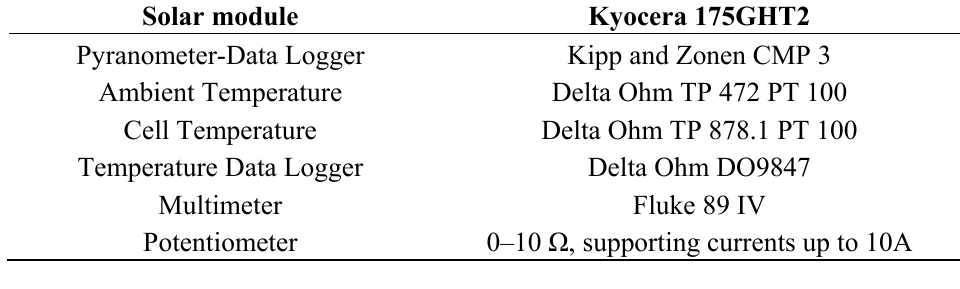
Table 1. Measurement setup.